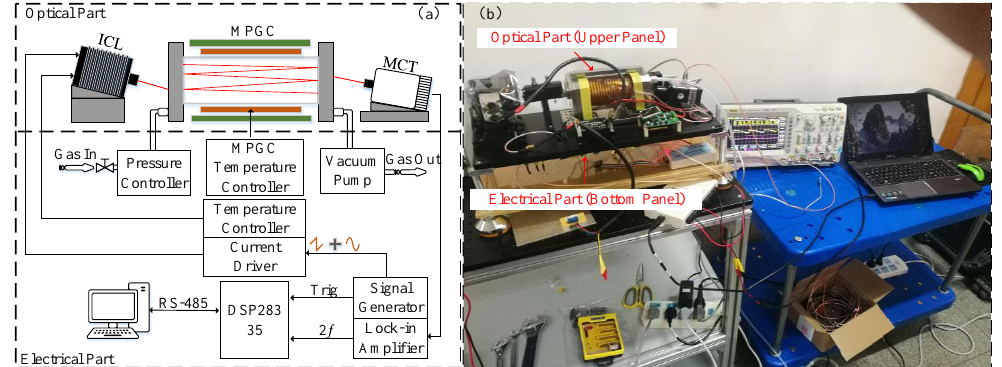
Figure 2. ( a ) Schematic block diagram of the sensing system including an optical part and an electrical part. ( b ) Gas sensor physical image including an optical part and an electrical part. MPGC: multi-pass gas cell; ICL: interband cascade laser; MCT: mercury cadmium telluride.